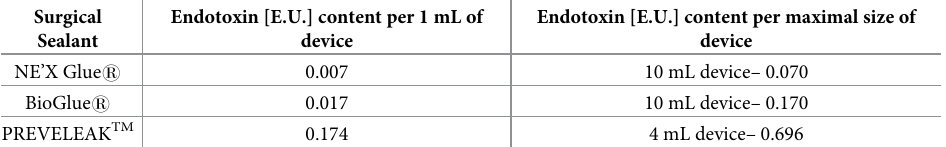
Table 2. Endotoxins concentration results.